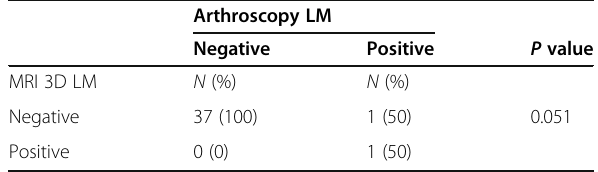
Table 6 Arthroscopic findings correlated with MRI protocol